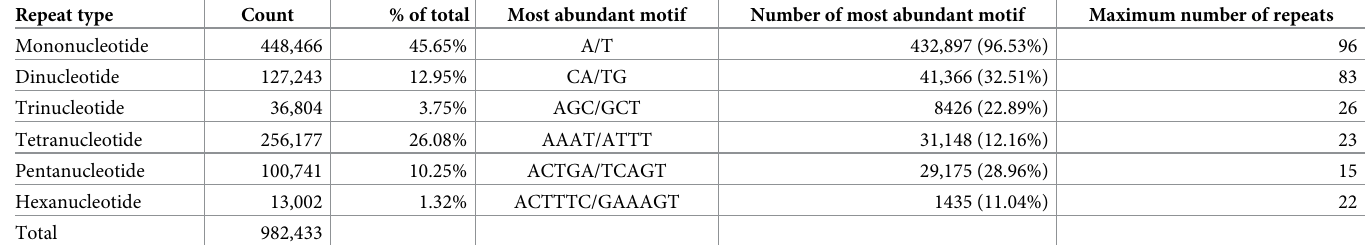
Table 1. Numbers and share of different microsatellite repeats, with the number and percentage of most abundant motif classes and maximum number of repeats in each repeat type in the red deer genome.